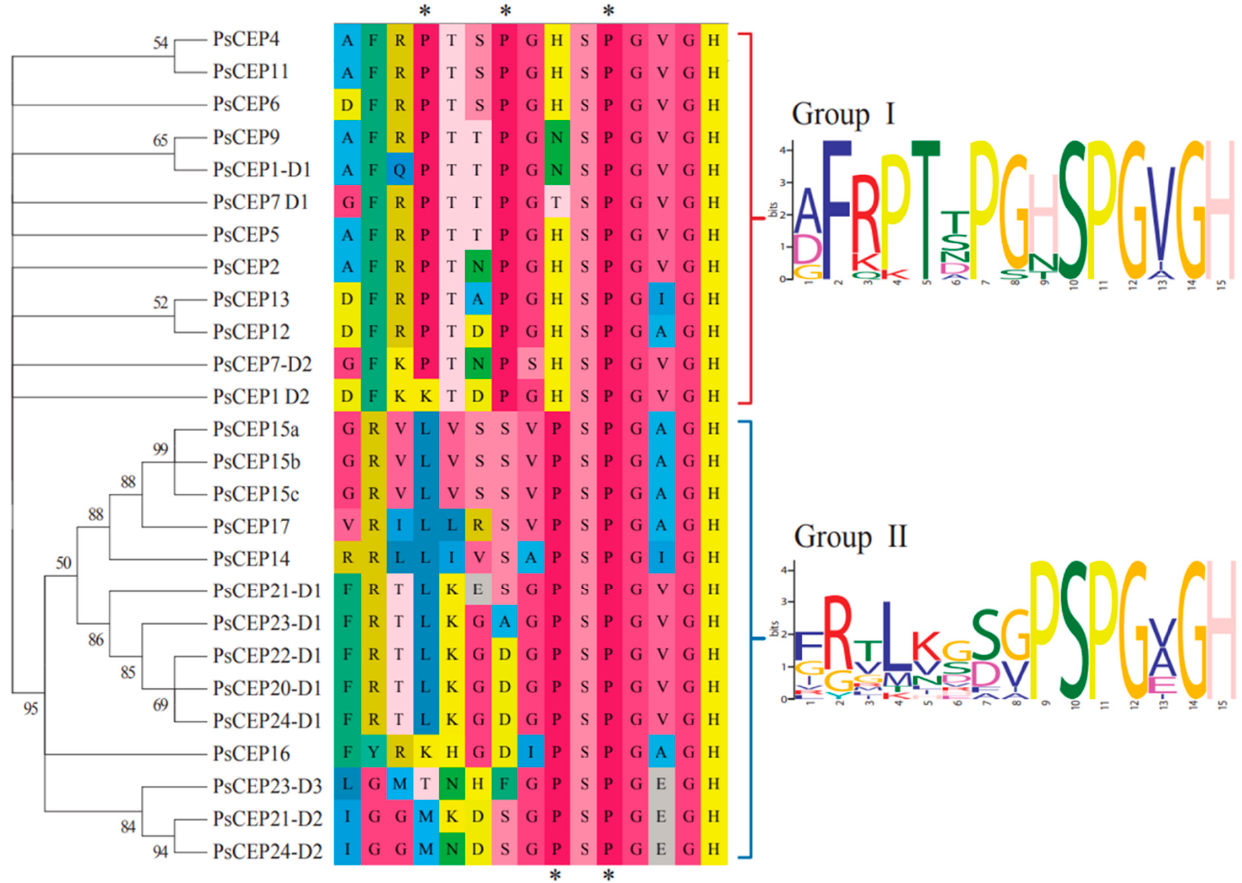
Figure 4 . Alignment of the PsCEP peptide sequences. WebLogo representation of the CEP domains from two groups is shown. Asterisks mark the conserved Pro residues found in two groups of the CEP domains.